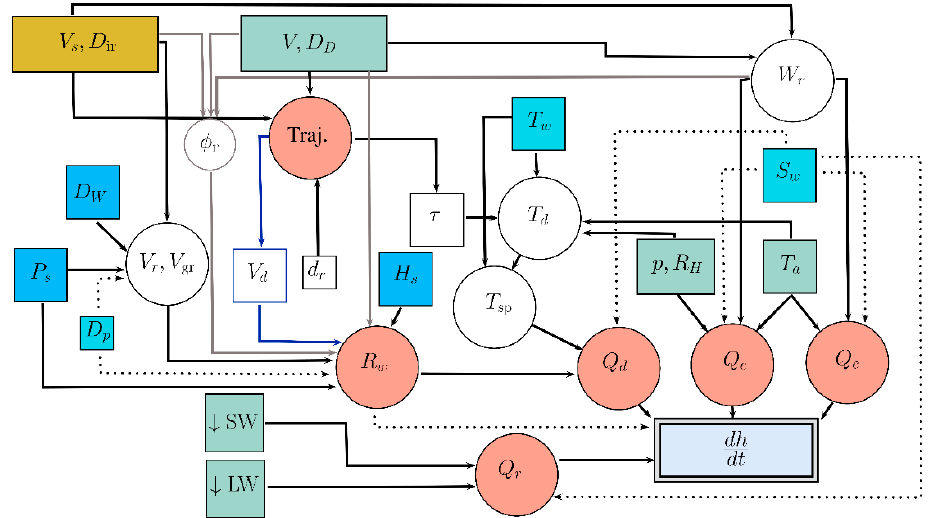
Figure 1. The Marine Icing model for the Norwegian Coast Guard (MINCOG) model-system includes input parameters (rectangles) from the atmosphere (green), the waves (blue), other ocean parameters (turquoise), the ship (yellow), and the final calculated icing rate dh / dt . Important processes like the trajectory model Traj ., spray flux R w , and calculation of heat fluxes Q , are marked with red circles. Dotted arrows represent more indirect or weaker effects. Blue arrows mark processes only involved when applying the Borisenkov spray-flux formulation. Grey arrows mark processes only involved when applying the Horjen spray-flux formulation. Black arrows mark processes involved when applying both spray-flux formulations. More detailed information on the model is given in Reference [1] .